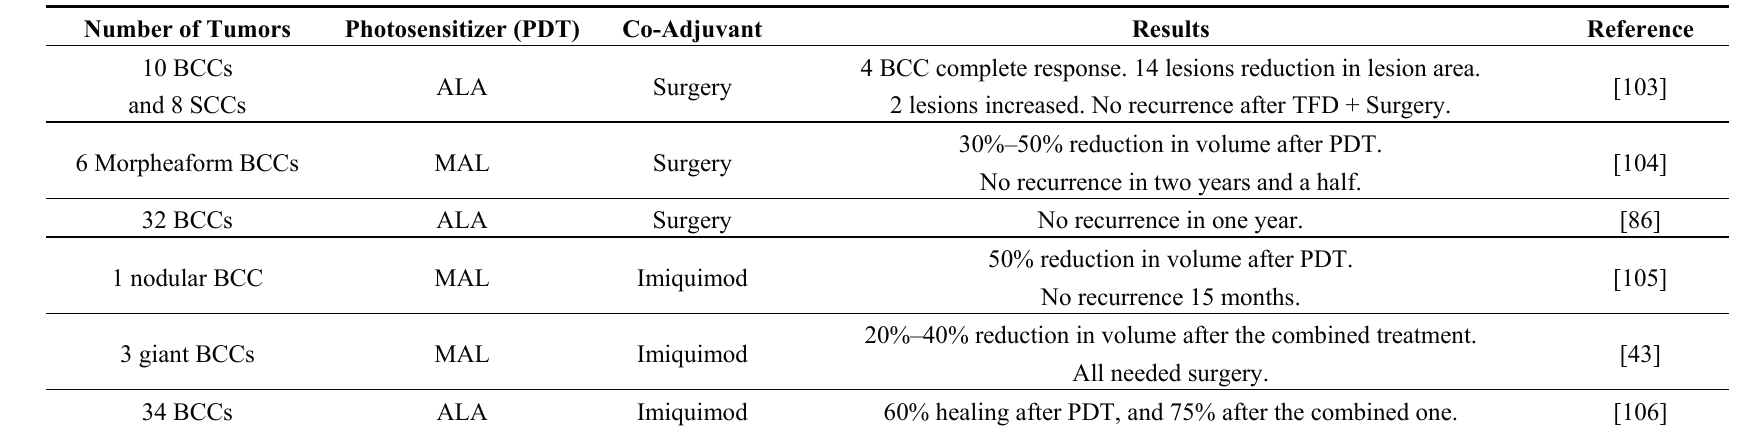
Table 3. Clinical studies of combined treatments with photodynamic therapy for basal cell carcinoma. Number of